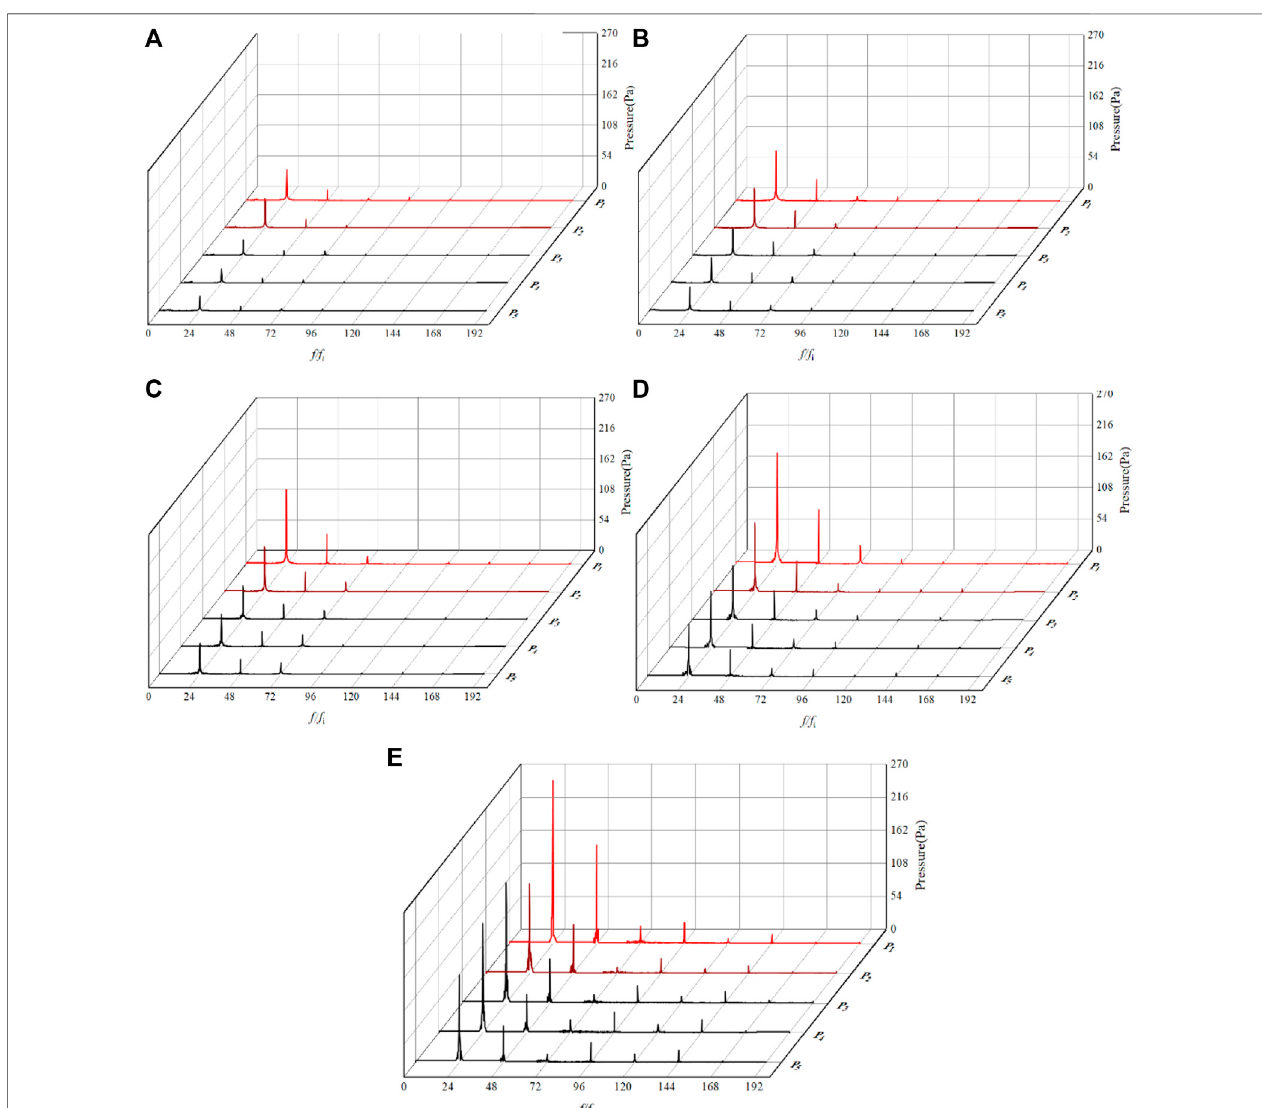
Frontiers in Energy Research |